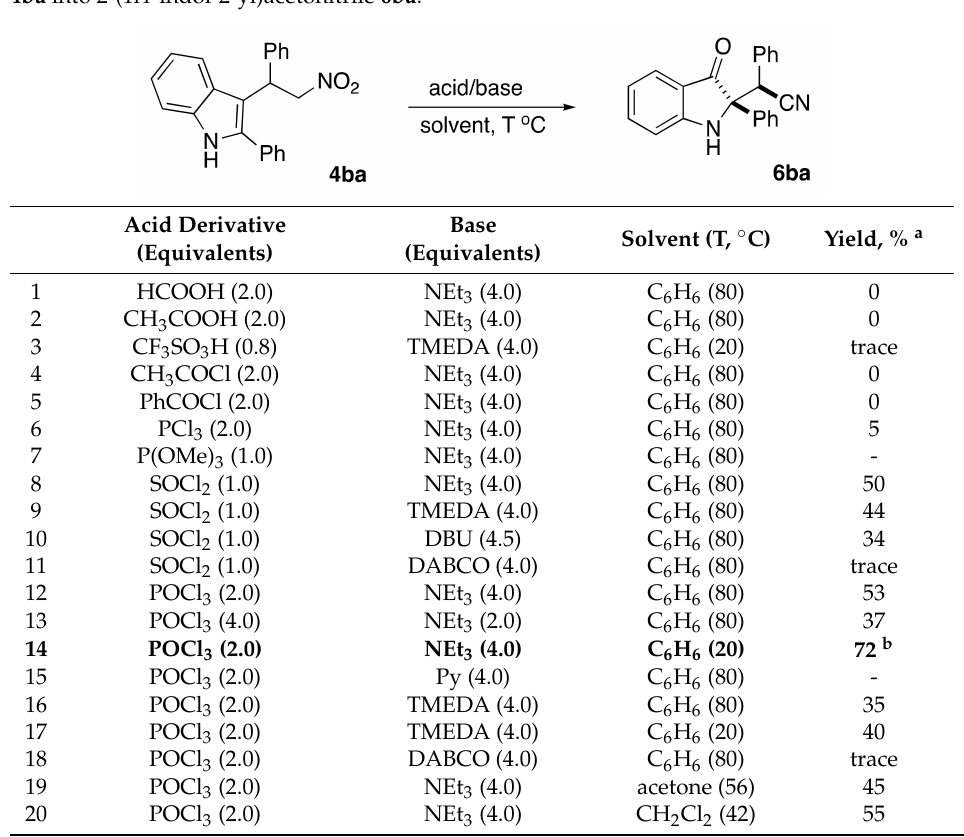
Table 1. Optimization of the reaction conditions for a direct conversion of 3-(2-nitroethyl)-1 H